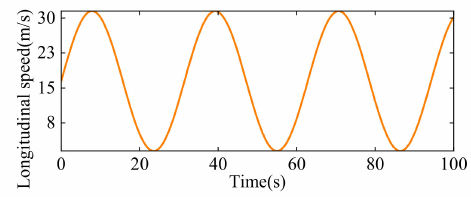
Figure 19. Sine longitudinal speed